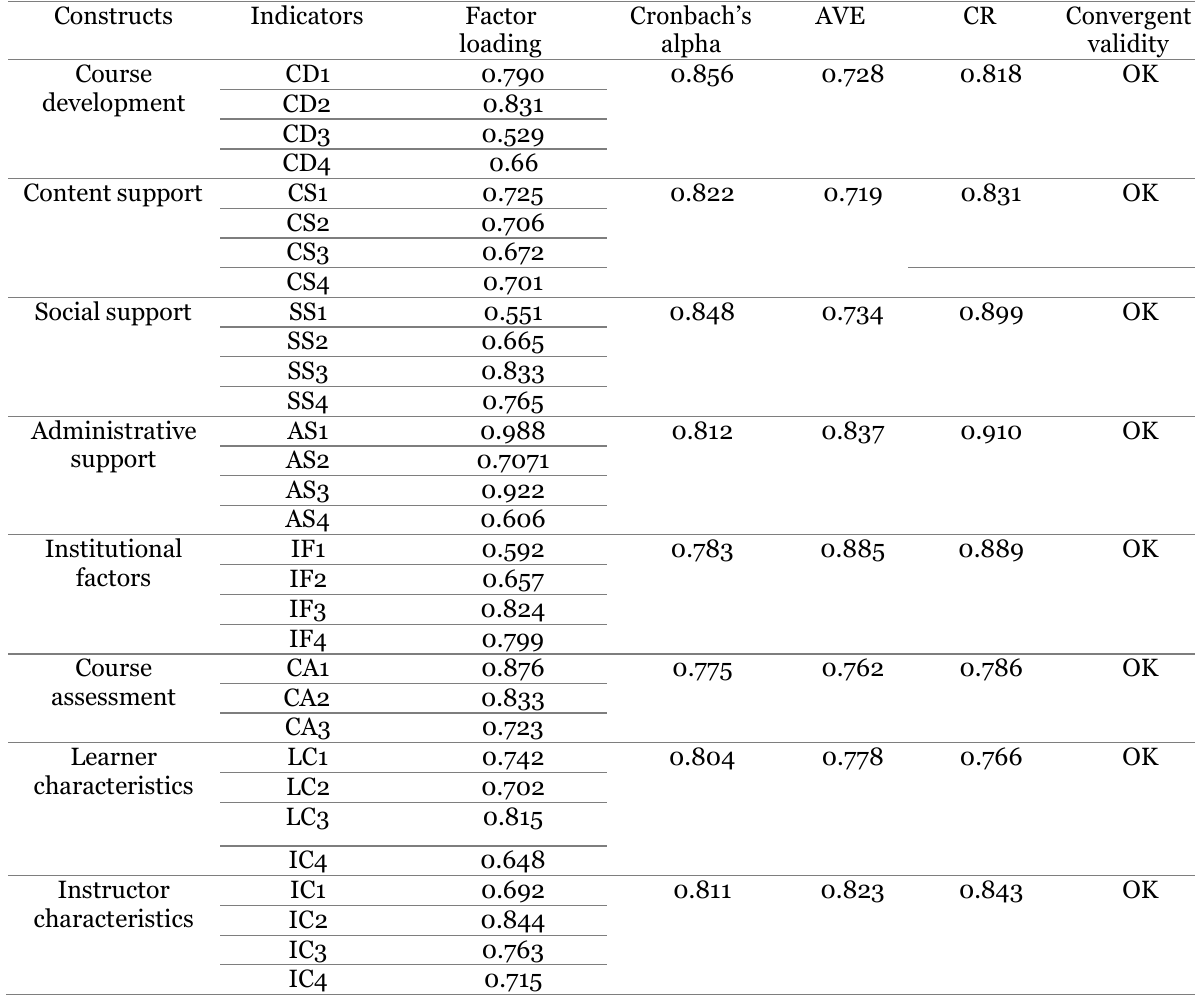
Table 3 Reliability and Convergent Validity